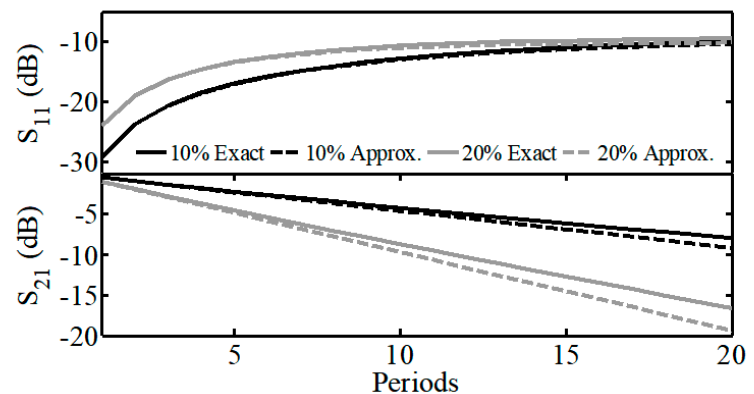
Figure 3. S -parameters as a function of the number of periods in the structure. Continuous line: exact calculation. Dashed line: approximate calculation from (1) and (2). The percentage indicates the power loss per pass of one period of the structure.